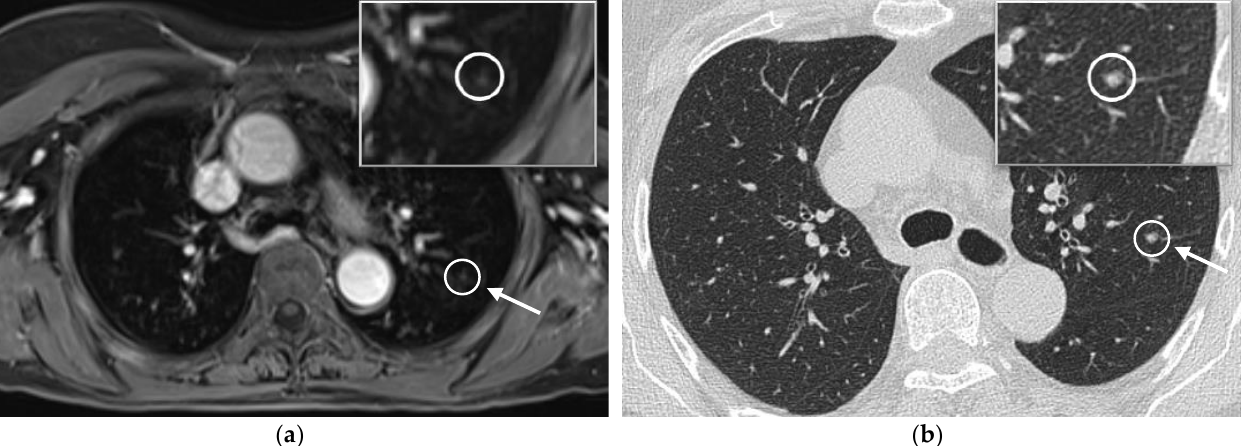
Figure 3. Example of the assessment of the lung in the 20-min-WB-MRI-protocol and the recommended further CT-scan: example of axial post-contrast T1w VIBE Dixon of the thorax ( a ) and CT-scan one week later ( b ) in a 73-year old patient with malignant melanoma and currently no evidence of disease. In the WB-MRI scan, a new pulmonary nodule (arrow) was detected and a further CT scan was recommended. Please note that the images have been cropped, as the skin tissue was part of the